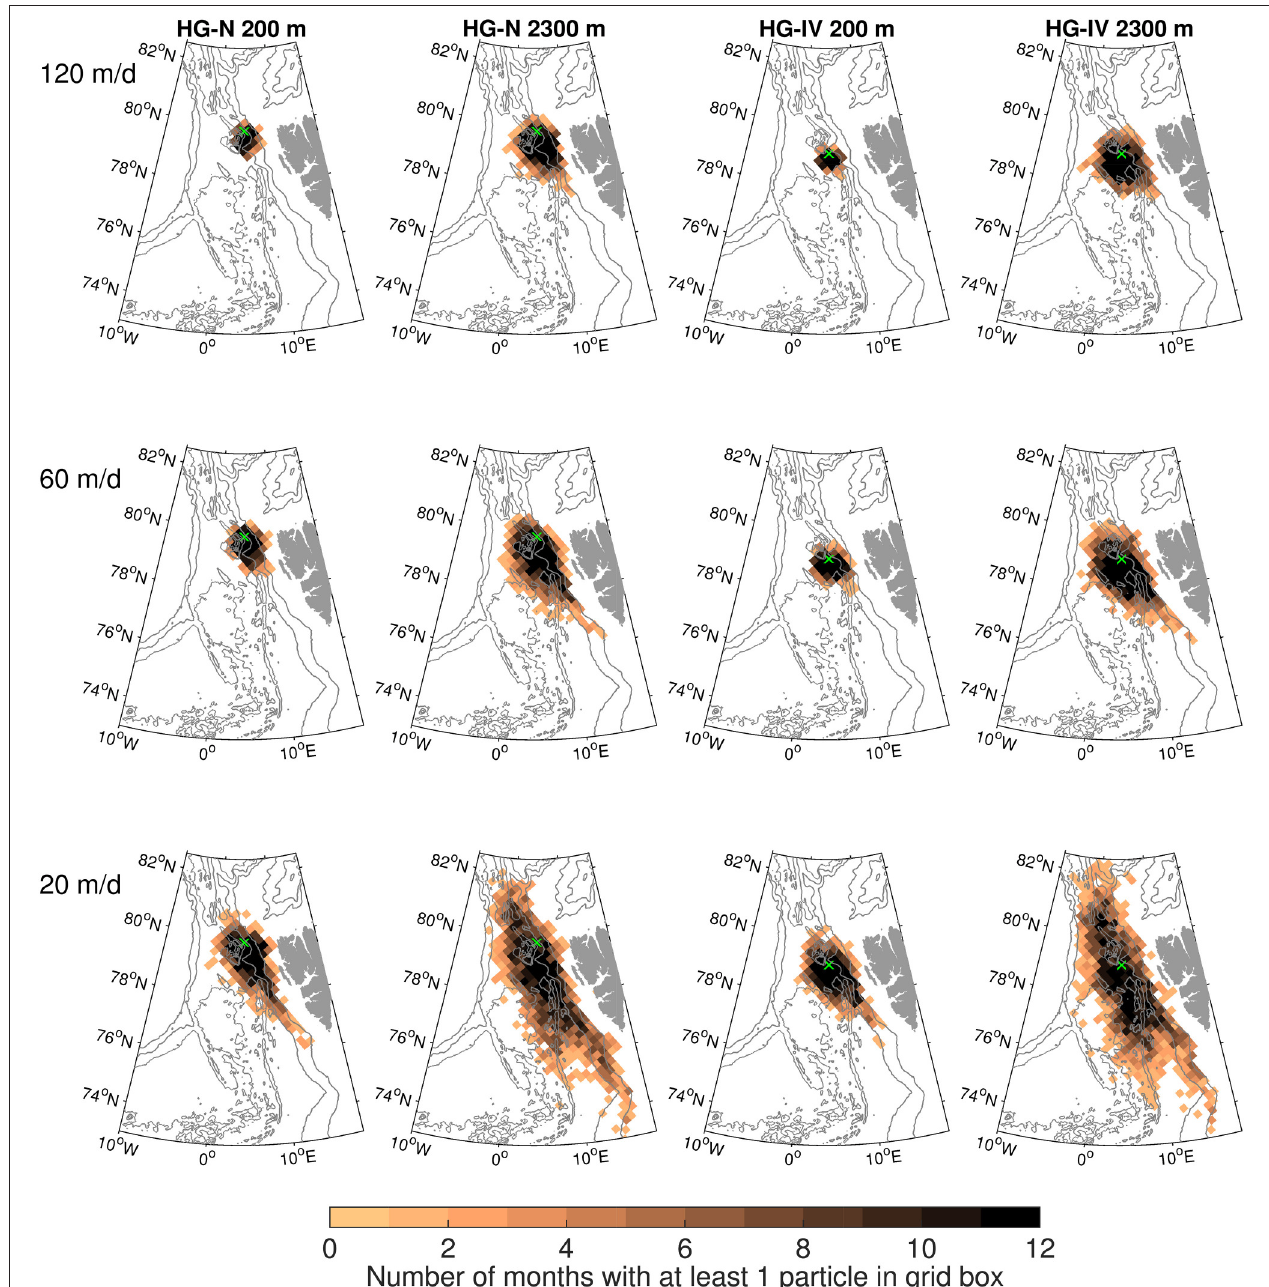
FIGURE 4 | Seasonal distribution of the catchment area for sediment traps HG-N and HG-IV, different depths of particle release (200 and 2,300 m) and settling velocities (120, 60, and 20 m/d): For each grid box of size 24 × 24 km, the number of months is shown in which at least one particle reaches the surface. The green cross indicates the mooring location. Gray contours show the bathymetry at 1,000 m intervals.